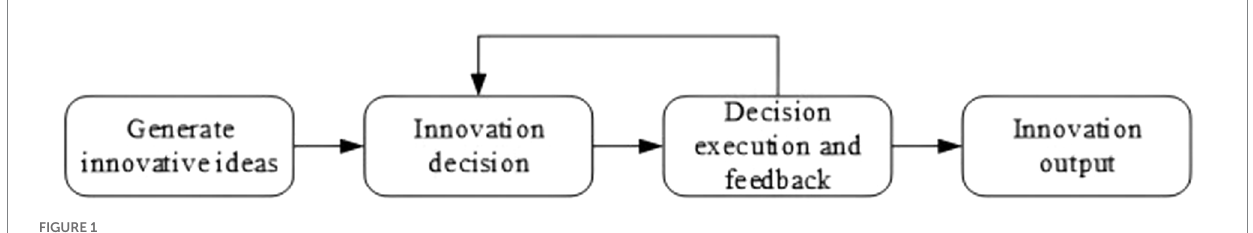
FIGURE 1 Enterprise innovation